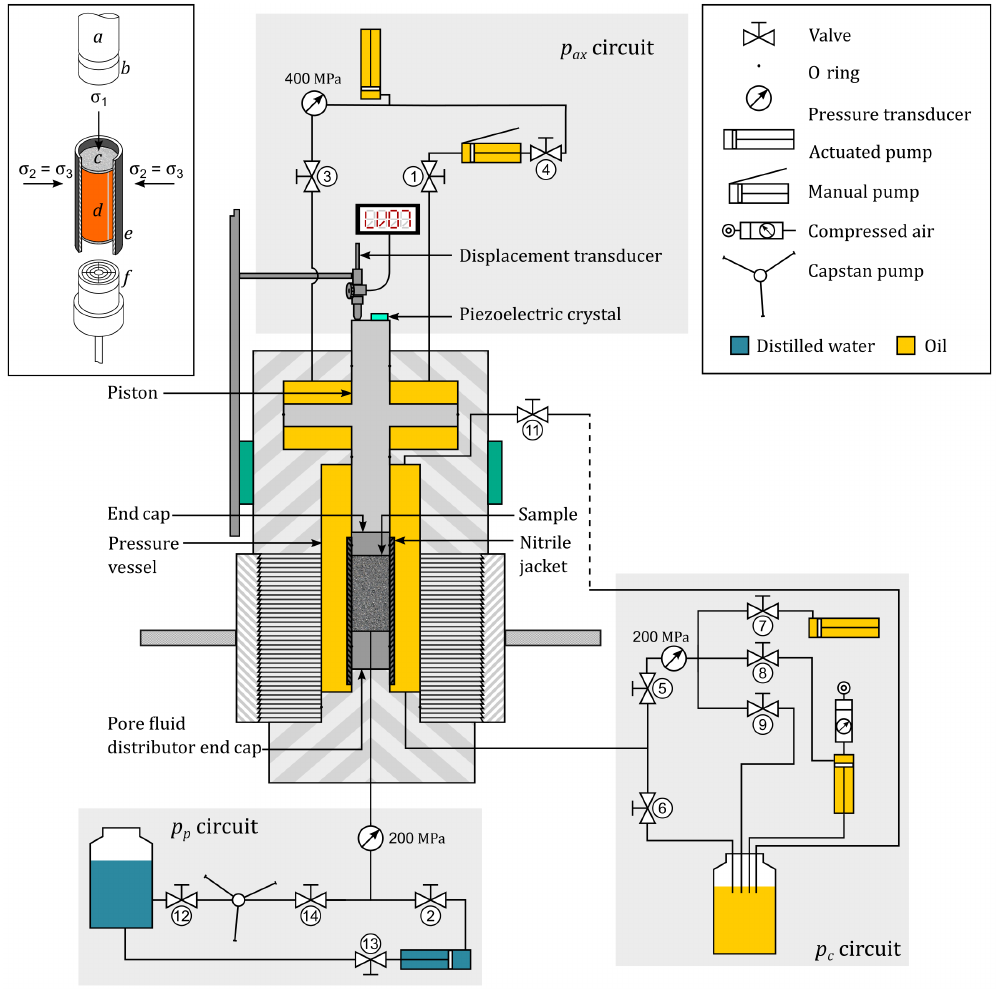
Figure 1. Schematic of triaxial deformation apparatus. Schematic of triaxial deformation apparatus, including confining pressure p c , pore pressure p p , and axial pressure p ax circuits. Detail of sample assemblage is shown in the inset. (a) Axial piston; (b) blank end cap; (c) sample; (d) copper foil jacket; (e) nitrile jacket; (f) and pore fluid distributor end cap. Directions of major σ 1 and minor σ 3 principal stresses are as shown, such that σ 1 > σ 2 = σ 3 . Not to scale. Numbered valves allow various parts of each circuit to be used at any given